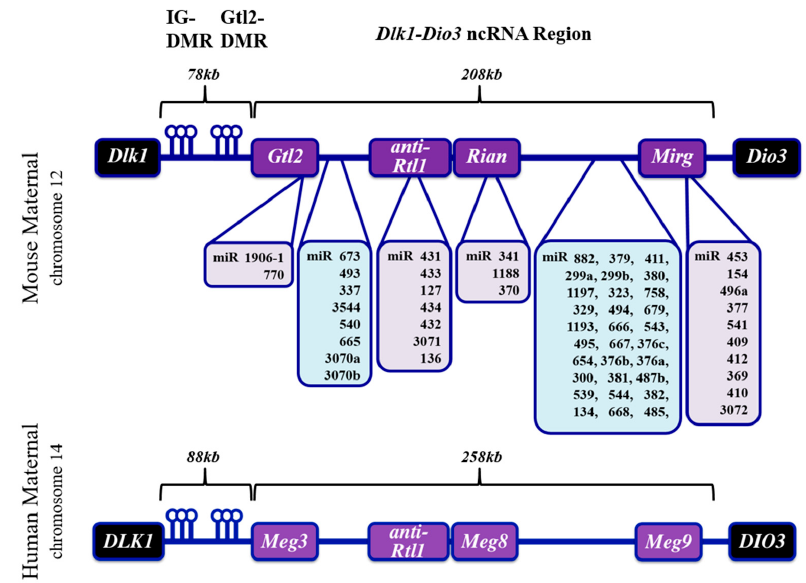
Figure 1. Schematic of Dlk1-Dio3 ncRNA locus features. The mouse Dlk1-Dio3 ncRNA locus (top panel) harbors sixty-one miRNAs and three lncRNA genes. Several miRNAs (shaded in light purple) reside within Gtl2 , anti-Rtl1 , Rian , and Mirg coding regions (shaded in light purple), whereas many miRNAs (shaded in light blue) exist between the aforementioned coding regions. The human DLK1-DIO3 ncRNA locus (bottom panel) harbors fifty-three miRNAs, which are largely present in the same regions as the mouse locus. Both loci are regulated by a 5 ′ intergenic differentially methylated region (IG-DMR), which is upstream of the Gtl2 -DMR. While most lncRNAs are homologous between mouse and human gene annotations, it is important to note the mouse Mirg lncRNA harbors miRNAs, whereas the human Meg9 lncRNA does not. Instead, Meg9 resides downstream of all annotated human locus miRNAs. NcRNAs are expressed from the non-methylated maternal allele, whereas methylation of the IG-DMR in the paternal chromosome (not depicted) prevents expression of ncRNAs. Protein-coding genes (shaded in black) are expressed predominantly from the paternal allele [33]. In humans, imprinting abnormalities at the Dlk1-Dio3 locus have been linked to syndromes of impaired fetal development and postnatal growth. Humans with uniparental disomy, that is, duplicate copies of either maternal or paternal chromosome 14q32 (MatUPD14 or PatUPD14), display